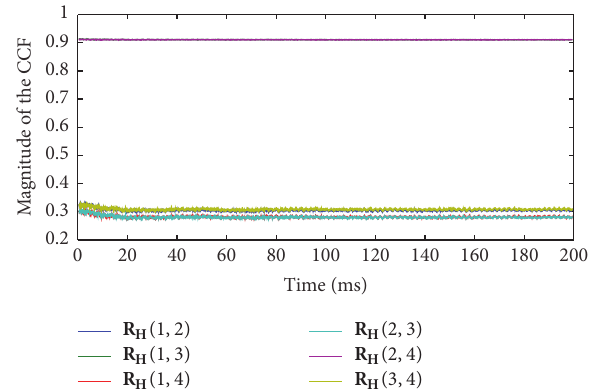
Figure 9: Magnitude of time-variant CCF between individual pairs out of four